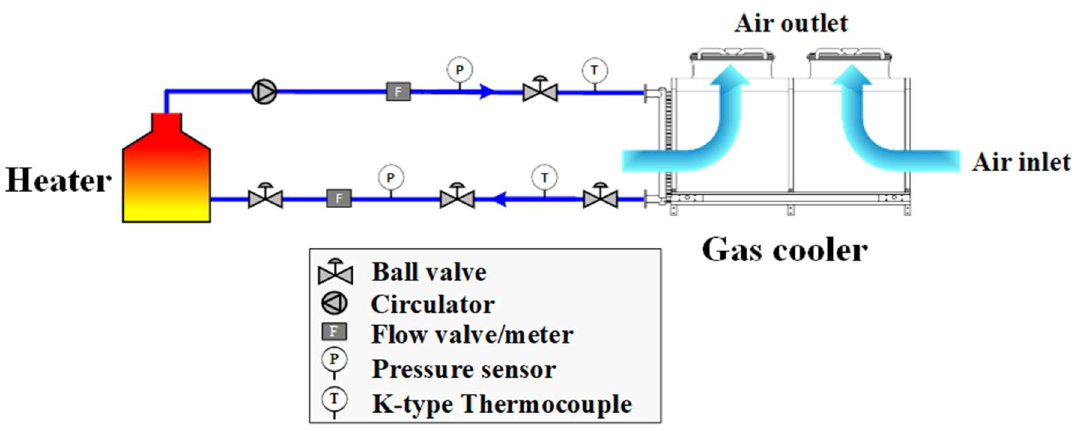
Figure 2. Schematic of the gas cooler test rig.